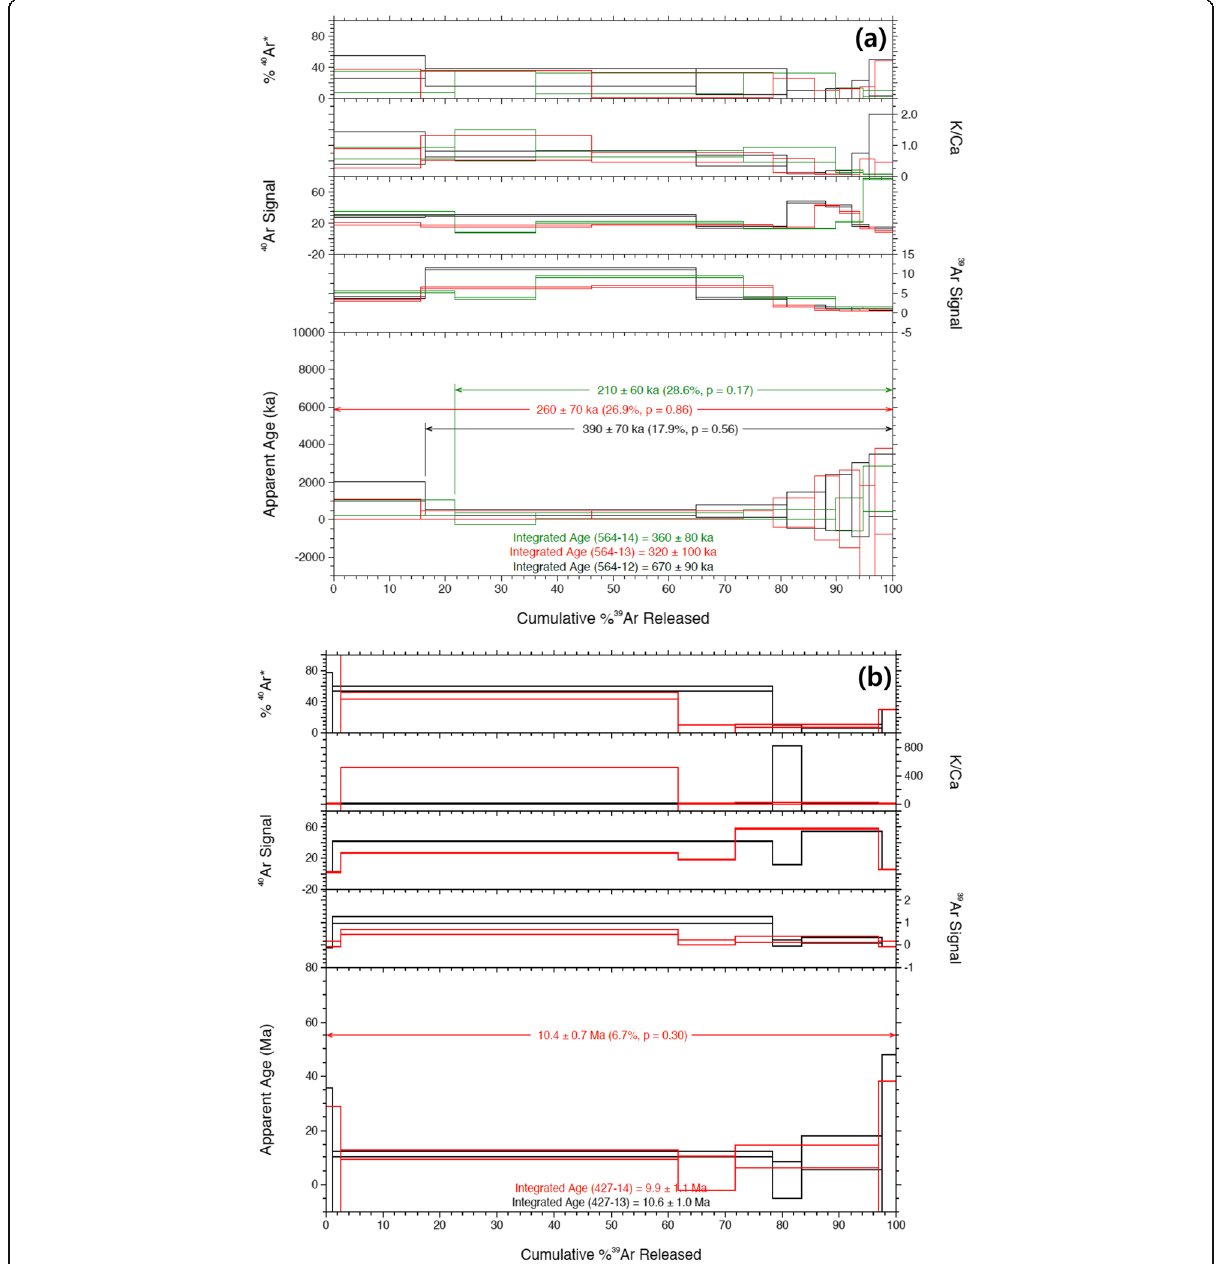
Fig. 3 Age spectra of ( a ) basaltic rock and ( b ) alunite with peak suppression measured under the original sample preparation